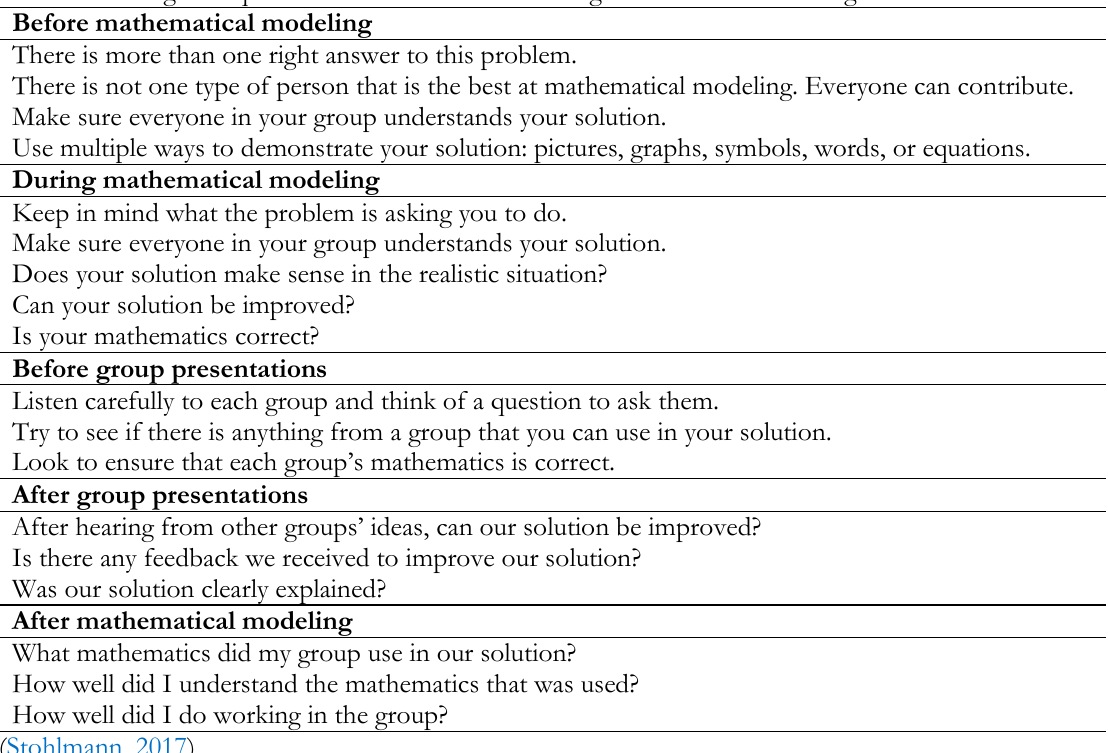
Table 1. Messages or questions for students when doing mathematical modeling Before mathematical modeling There is more than one right answer to this